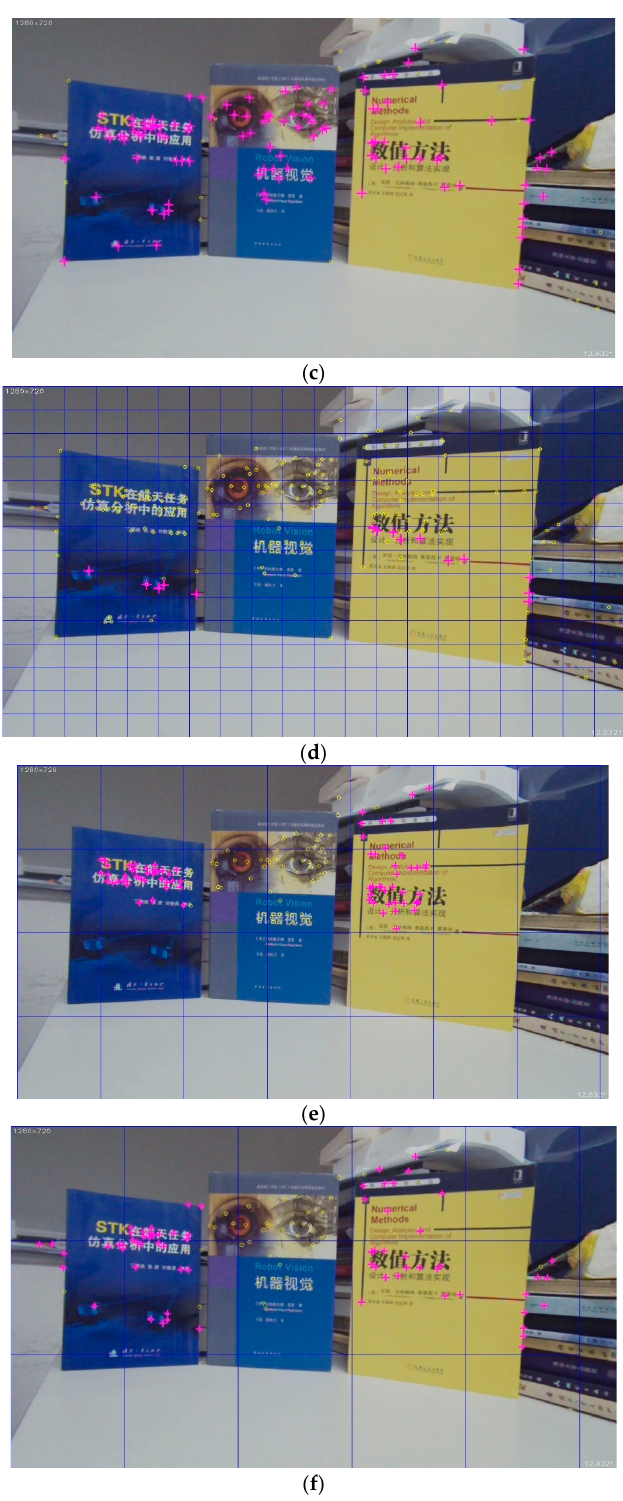
Figure 3. Real example for static extraction. ( a ) and ( b ) are source images, which show that the book in the middle is moving. ( c ) The static points recognized by RANSAC, marked with red crosses. The outliers are marked with yellow circles. ( d ) The static points recognized by ARSAC [16]. ( e ) The static points recognized by our DLRSAC with the size of grid is 180 × 180. ( f ) The static points recognized by our DLRSAC with the size of grid is 240 ×